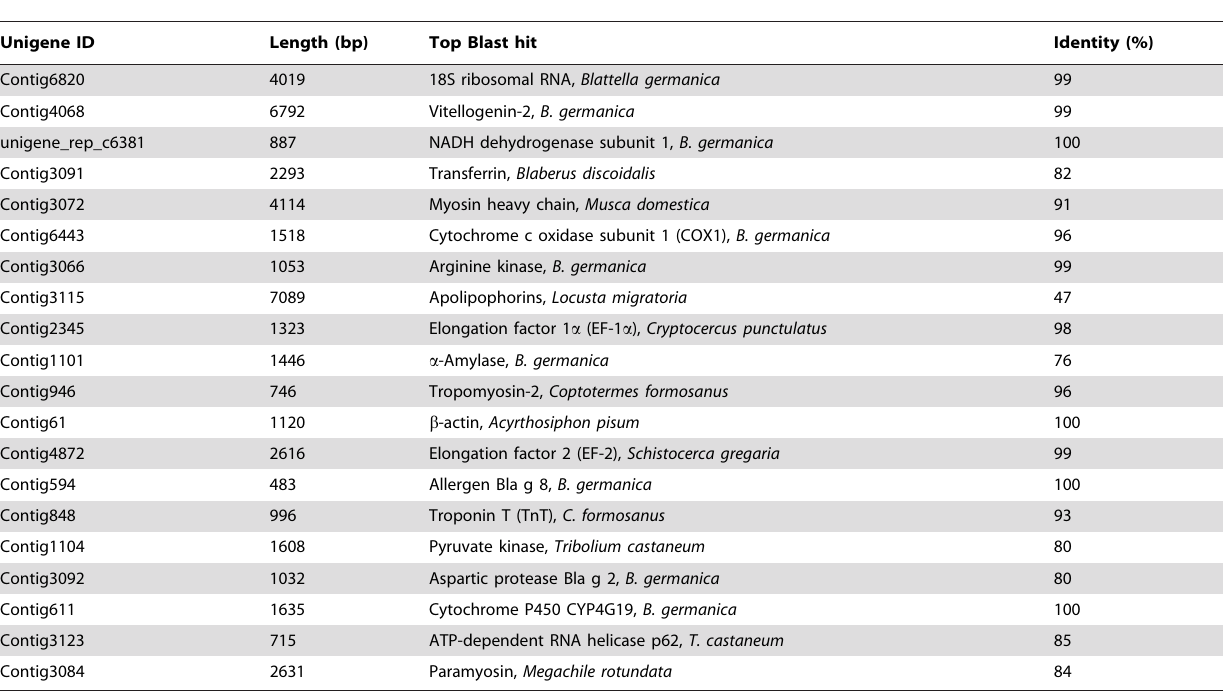
Table 2. Summary of top 20 abundant assembled unigenes from the German cockroach transcriptome. Unigene ID Length (bp)